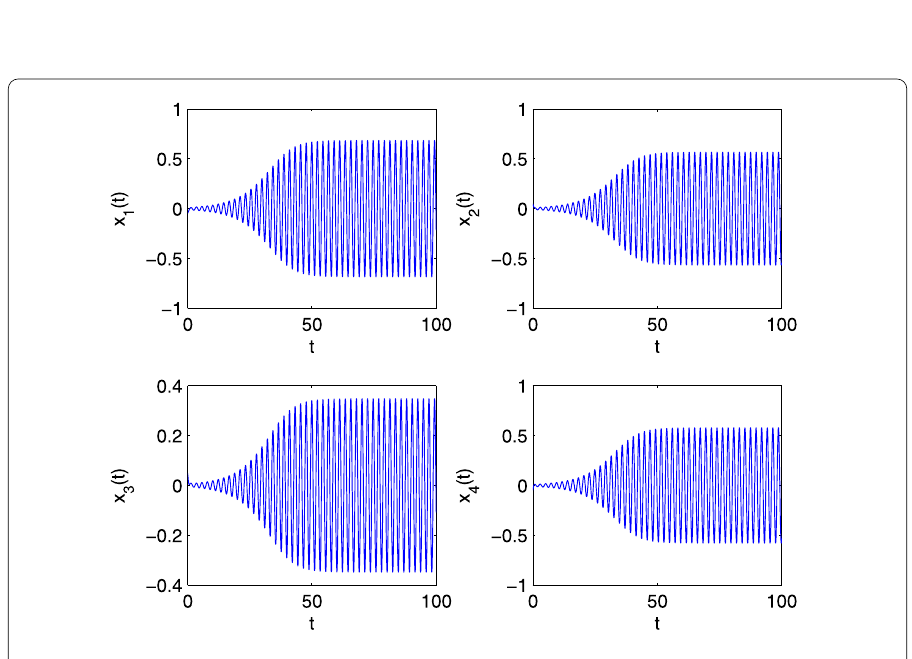
Figure 16 State response of system (5.4) with φ = 0.96, τ = 0.28 > τ 0 =